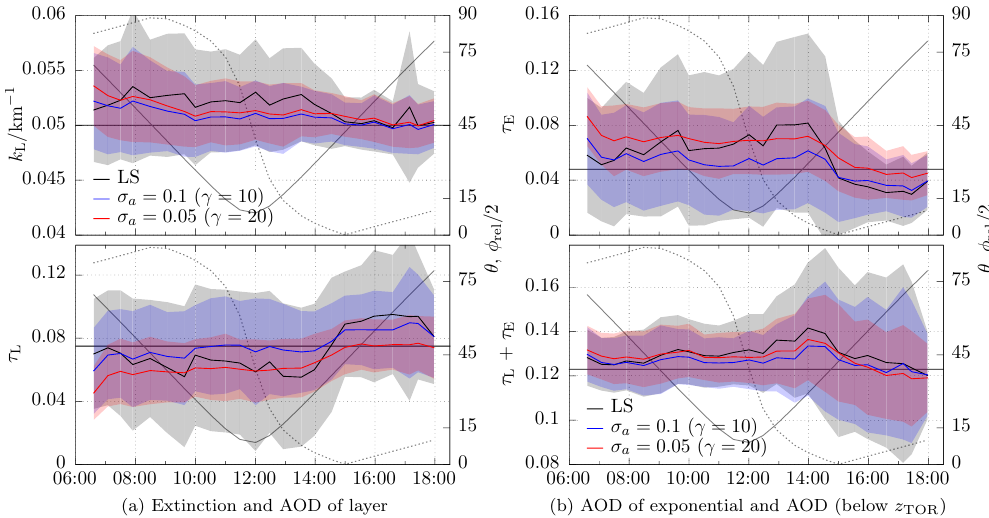
Fig. 10. Retrieval of x =( k L · 1km, τ L , τ E ) T for the ground layer profile with τ ∼ 0.12 (Fig. 2, top row, viewing direction west) for the unregularised (LS) and regularised problem and a random measurement error with σ (cid:15) = σ (cid:15) and shaded areas the standard deviations. Compare to Fig. 3 ( a , top